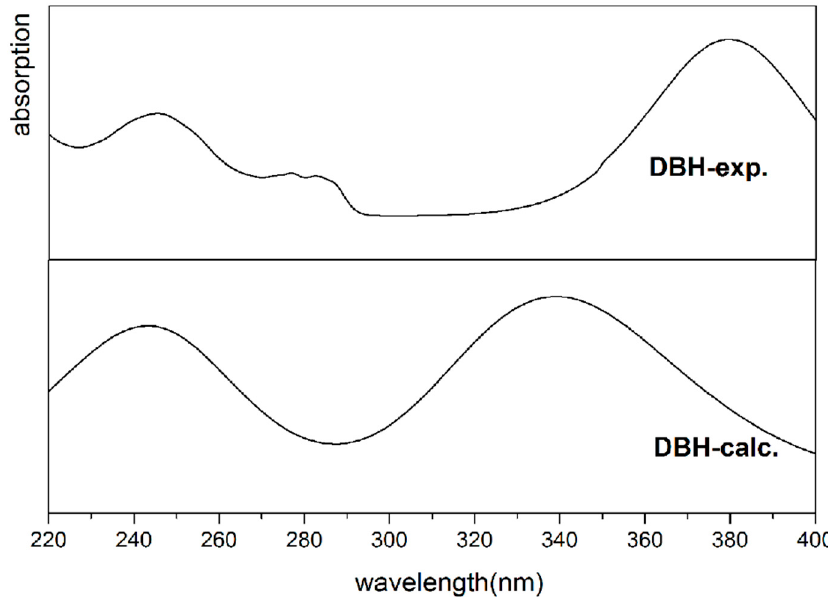
Figure 5. Experimental and calculated UV–Vis spectra of DBH .